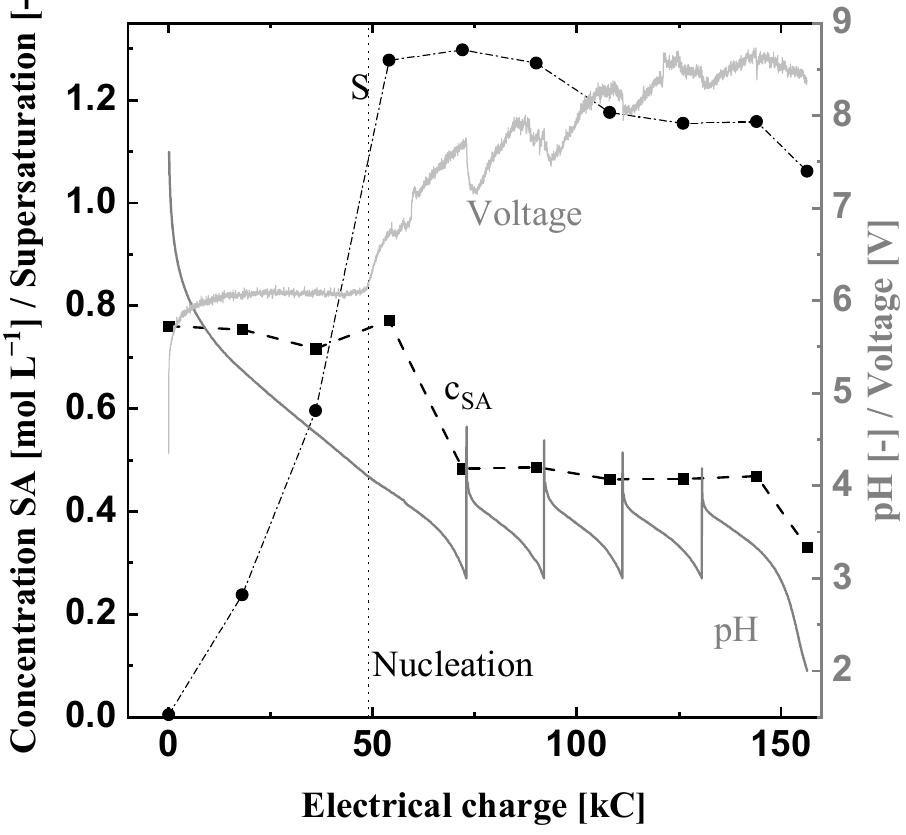
Figure 7. Electrochemical pH-shift crystallization in the prototype at 10°C, 0.05Acm − 2 and a volume flow rate ˙V of 0.52Lmin − 1 (Exp3). The black squares are the measured succinic acid concentration, the black cycles show the calculated supersaturation ratio S, and the two gray lines display the course of the pH value and voltage of